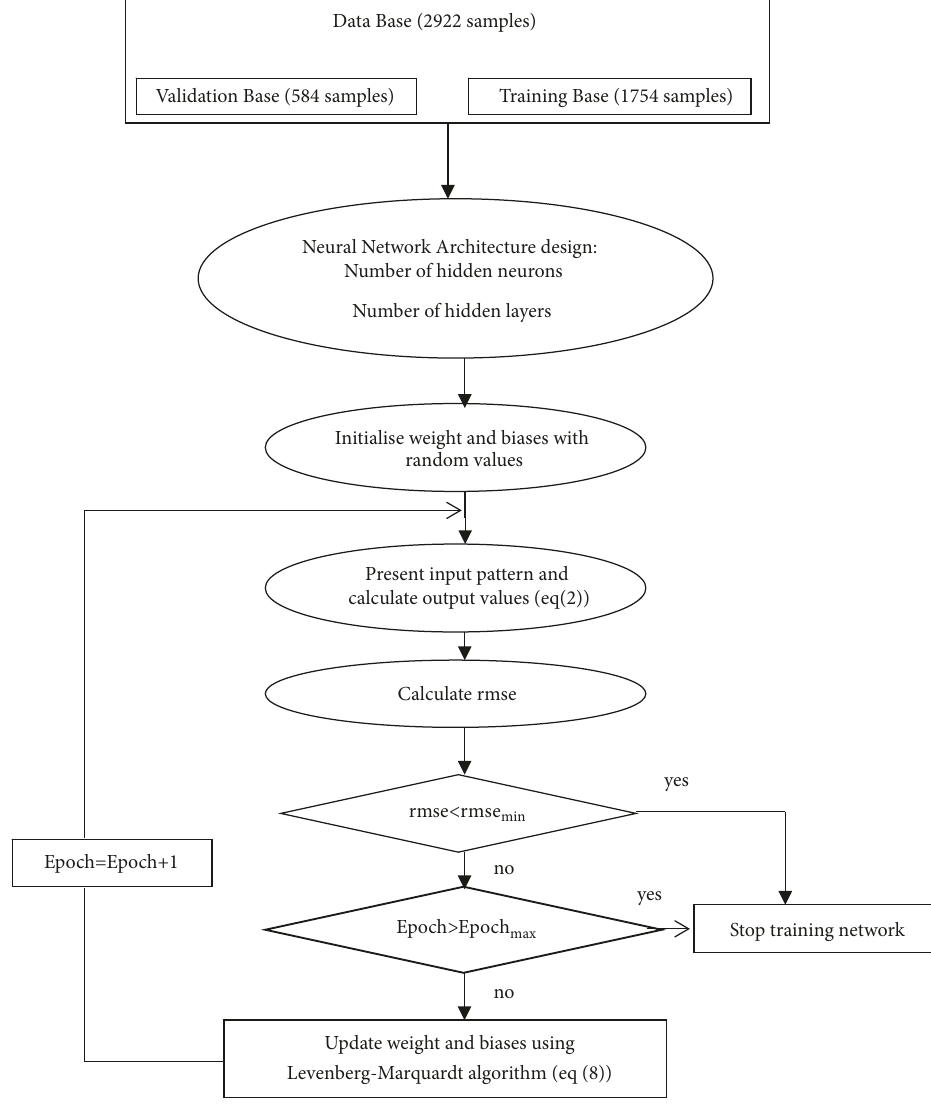
Figure 6: General layout of the neural